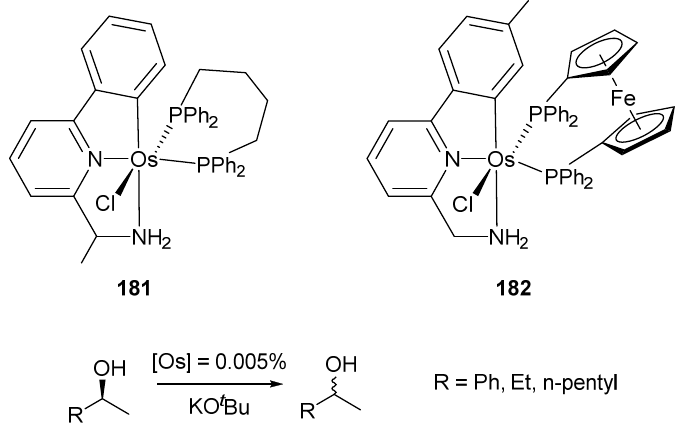
Figure 40. C~N~N pincer complexes used for racemization of chiral alcohols.